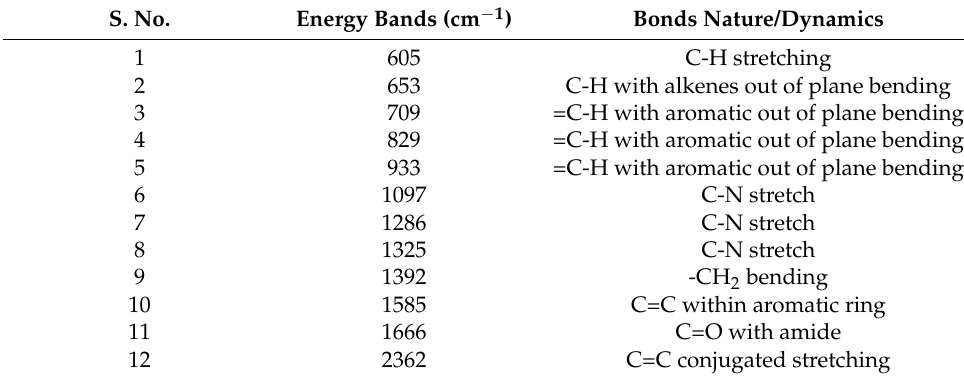
Figure 5. FTIR spectrum of PAD. Table 1. Vibrational bond dynamics of